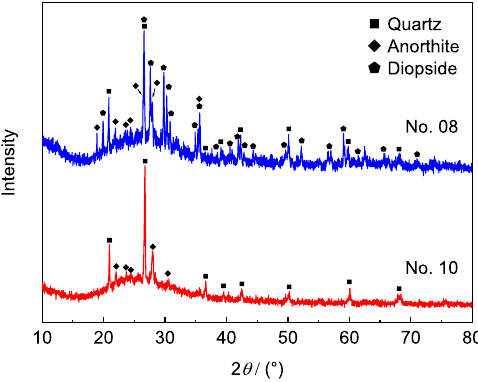
Fig. 8 XRD diagrams acquired on the glaze surface of Nos. 08 and 10. The diffraction peaks of quartz and anorthite exist both in the two samples, while diopside exist only in No. 08.